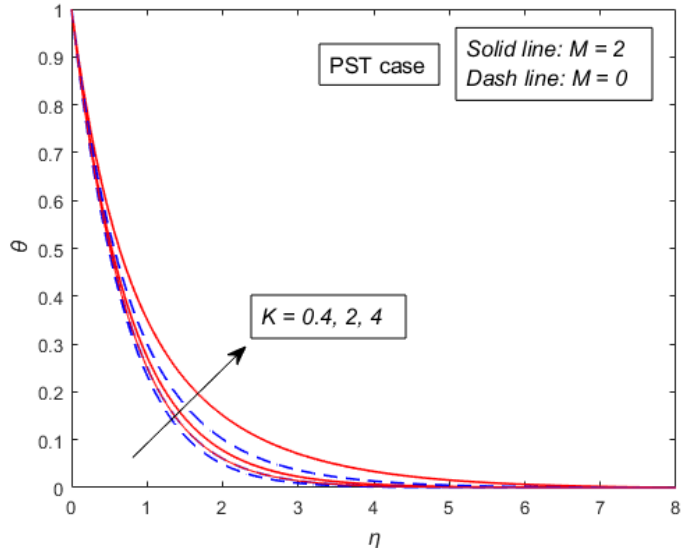
Figure 6. Variation of the temperature profile for different values of viscoelastic parameter K and magnetic parameter M for the PST case when n = 3, Pr = 0.71, and Ec =